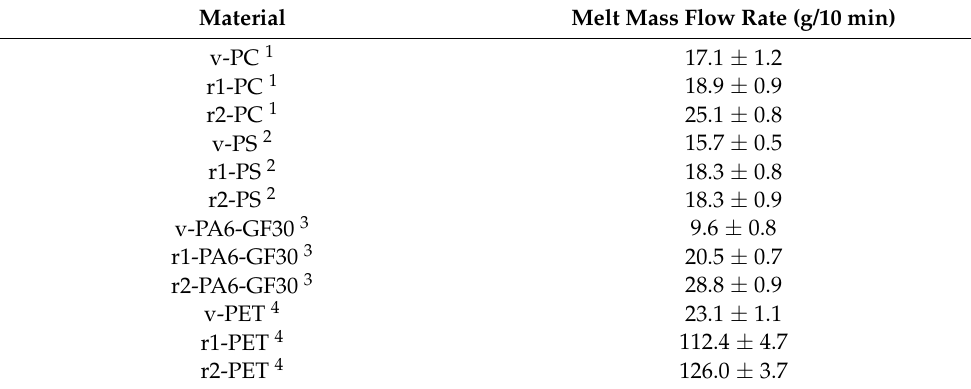
Table 3. Melt mass flow rate results for virgin and recycled materials tested according to the guidelines in ASTM D1238-13 [21].